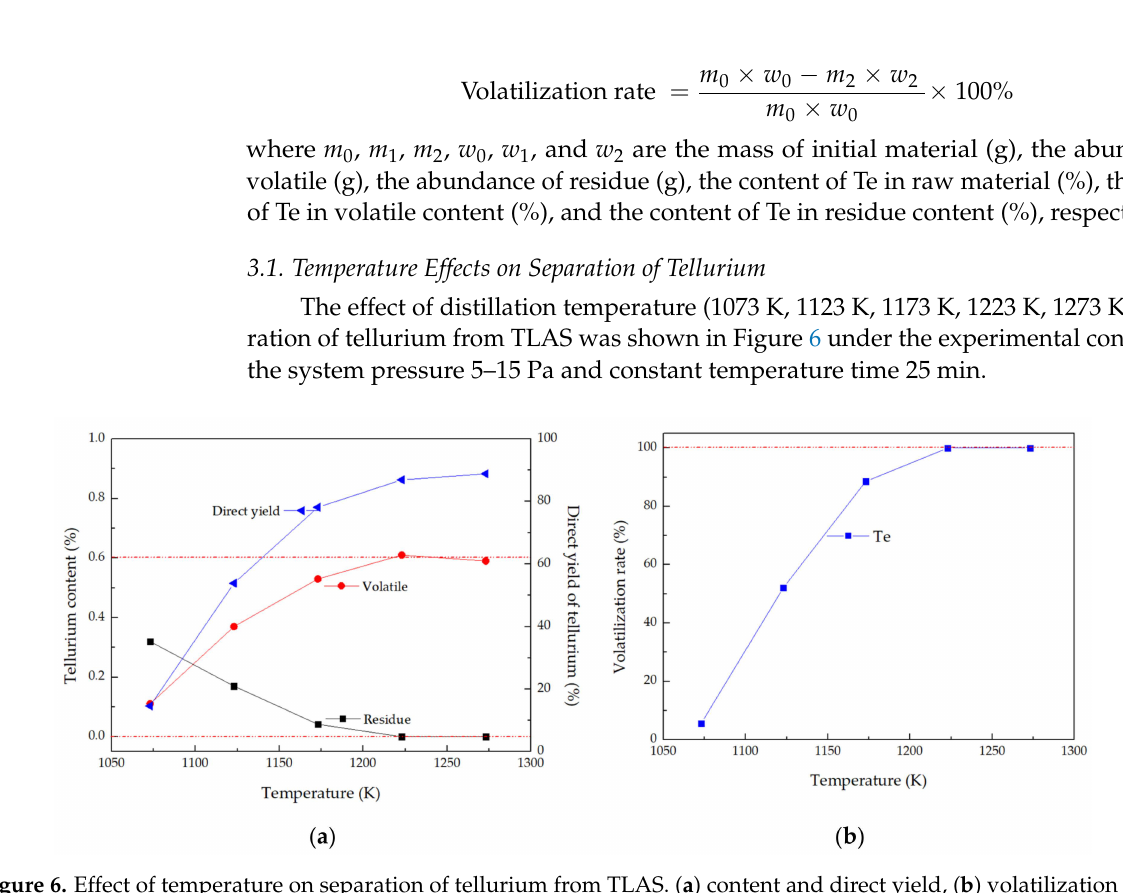
Figure 6. Effect of temperature on separation of tellurium from TLAS. ( a ) content and direct yield, ( b ) volatilization